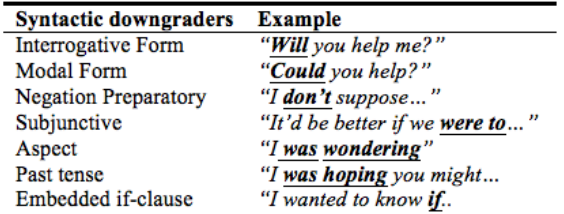
Head Act Taxonomy: Internal Modification - Syntactic and Lexical